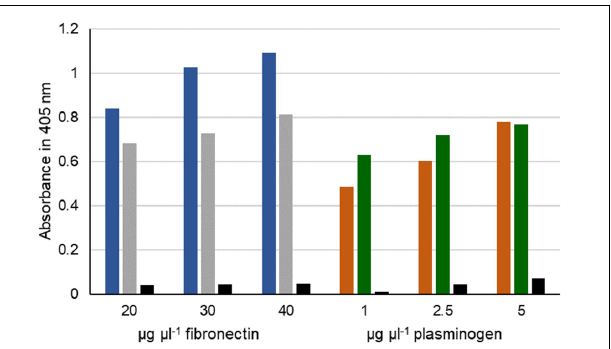
FIGURE 7 | Interaction of fibronectin and plasminogen with IbpM. Purified IbpM (blue and brown) or whole cells of M. pneumoniae (gray and green) were coated onto 96-well plates and incubated with different concentrations of fibronectin (left) or plasminogen (right). Interaction of IbpM with the human proteins was quantified with peroxidase-conjugated antibodies detecting the corresponding human proteins. Absorbance was detected at 405 nm. BSA (black bars) served as negative